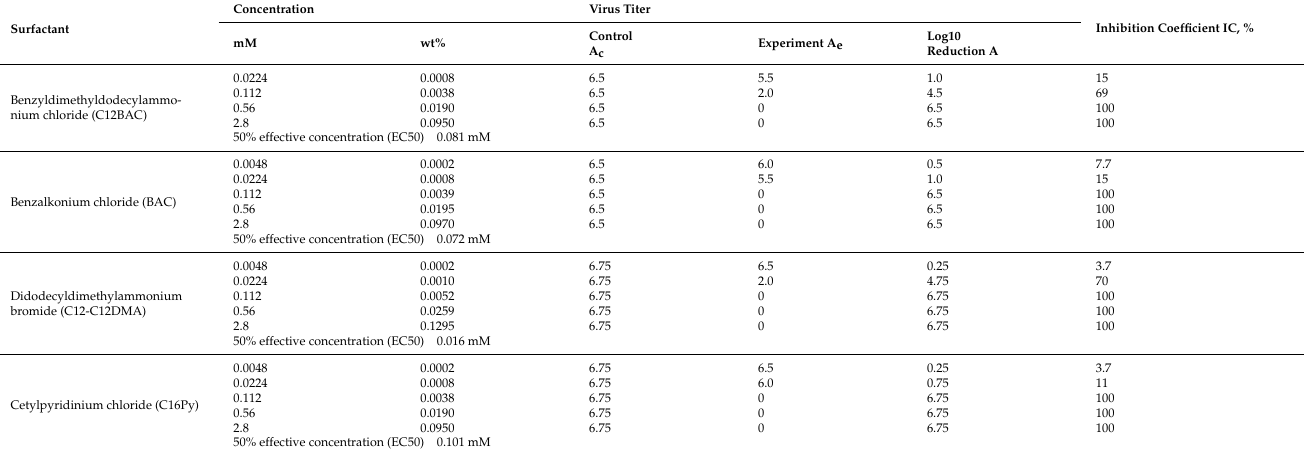
Table 2. SARS-CoV-2 inactivation by cationic surfactants of different concentrations (contact time 1